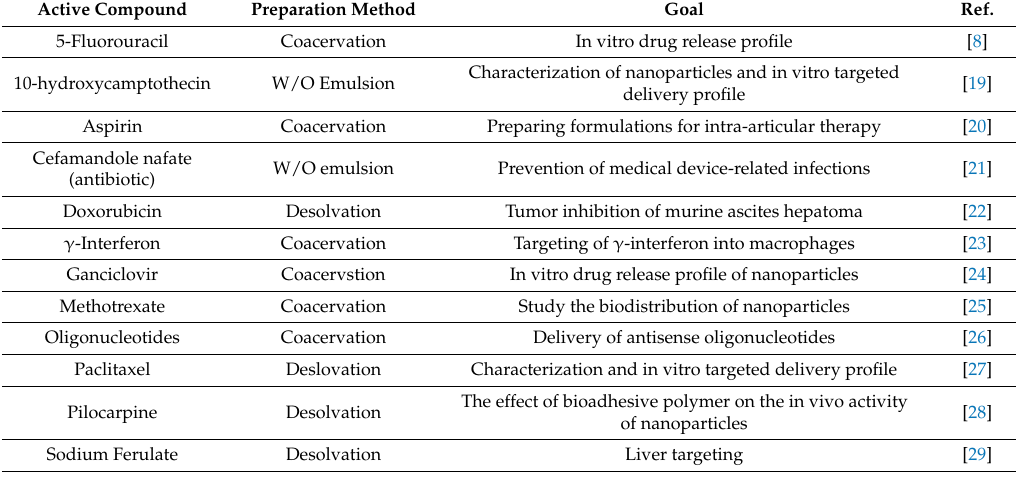
Table 1. Active compounds encapsulated within bovine serum albumin (BSA) nanoparticles. Active Compound Preparation